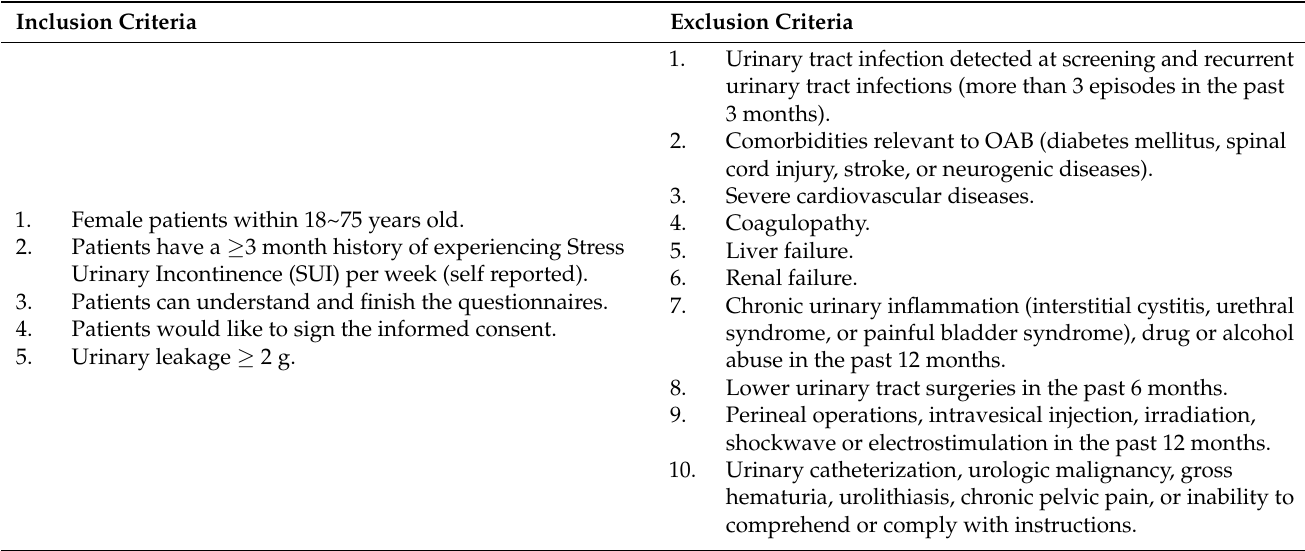
Table 1. Inclusion and exclusion